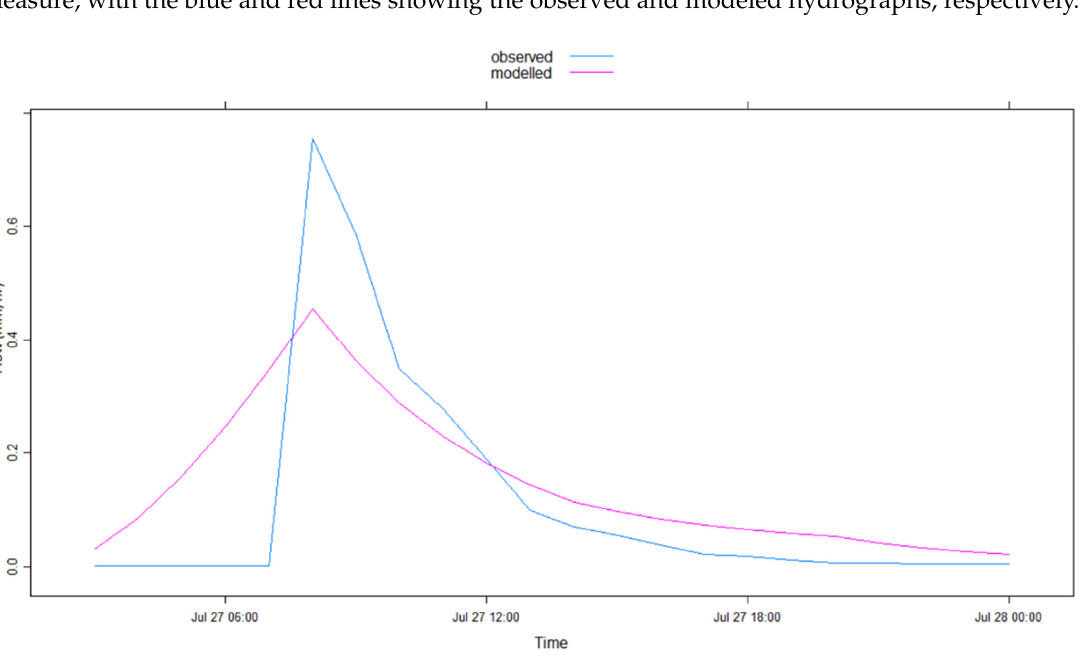
Figure 4. IHACRES model simulation results with rsq_hourly objective function for the 2000 flood event. IHACRES—identification of unit hydrographs and component flows from rainfall, evapotranspiration and streamflow data